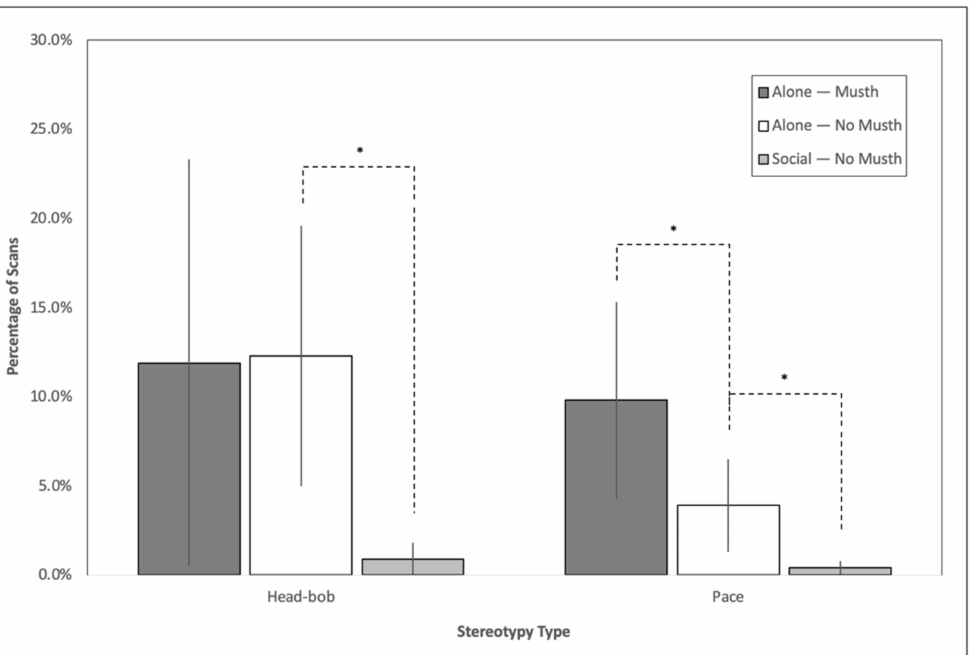
Figure 1. Percentage of scans engaged in stereotypy when socialized compared to alone and when in musth vs. not in musth. Only one individual (Individual 3) exhibited head-bobbing during our study, and Individuals 1, 2, 3, and 4 exhibited pacing. Individual 5 did not engage in stereotypy, and Individuals 4 and 5 did not undergo a musth period during our study. During non-musth observations, the elephants engaged in less head-bobbing and pacing when they were housed with at least one other bull compared to alone (head-bobbing p < 0.001; pacing p = 0.005). When alone, the elephants engaged in significantly more pacing when they were in musth than when they were not in musth ( p < 0.001). Musth did not significantly impact Individual 3 (cid:48) s head-bobbing ( p = 0.685). Error bars represent 95% confidence intervals. * indicates p <